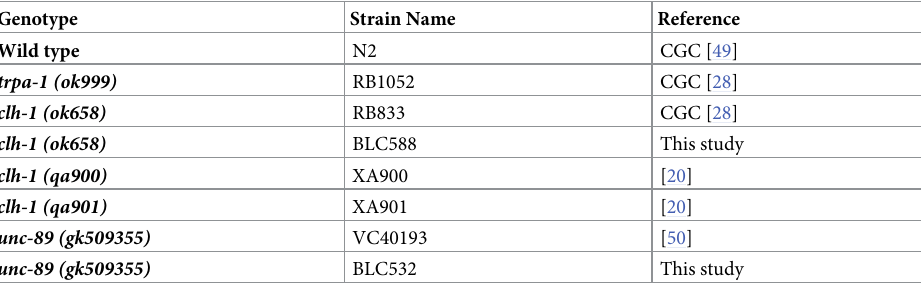
Table 3. Nematode strains used in this